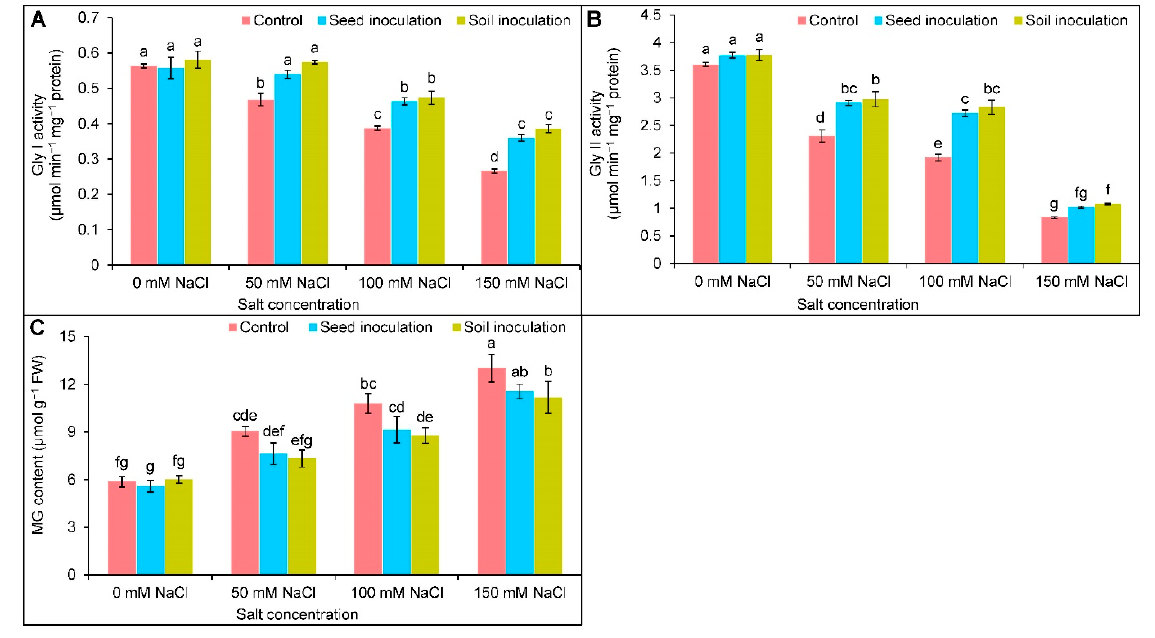
Figure 9. Effect of Bacillus subtilis in response to different concentrations of salt stress on the activities of Gly I ( A ), Gly II ( B ), and MG content ( C ) of soybean ( Glycine max cv. BARI Soybean-5). Values in a column are mean ± SD. Different letters on each bar indicate significant differences among the treatment after applying a Tukey’s HSD test at p ≤ 0.05.